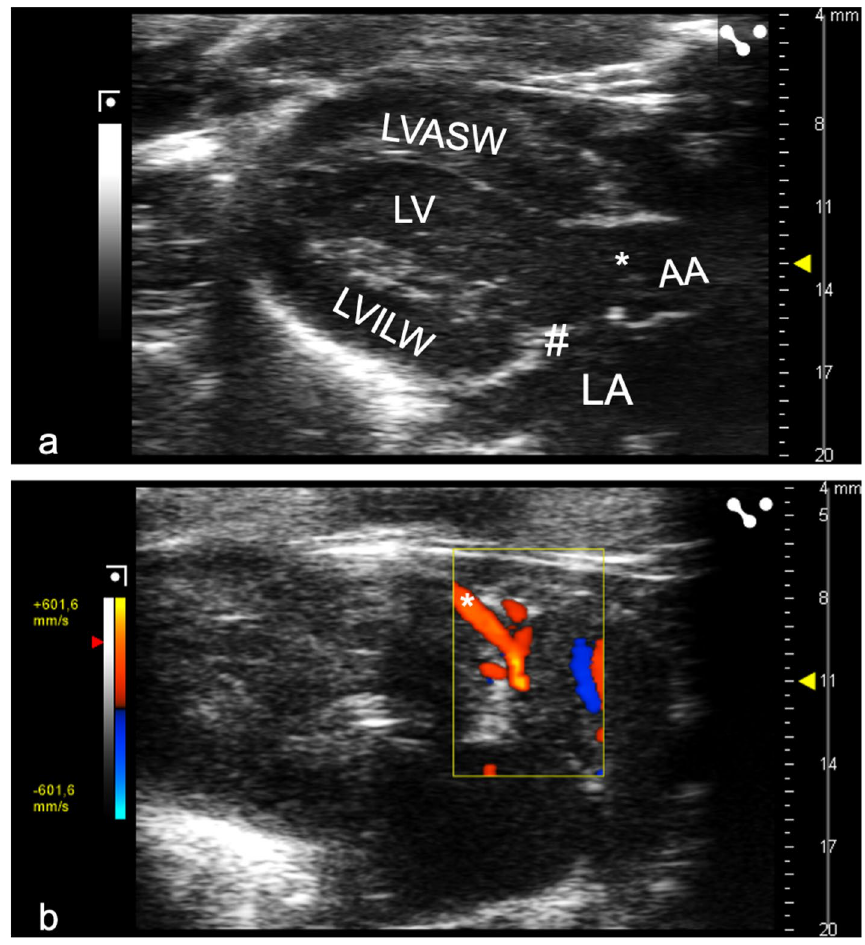
Fig. 2 Representative B-mode and colour Doppler images acquired in a parasternal long axis (PLAX). a B-mode PLAX of the left ventricle. These images were used for volumetric and perfusion measurements. AA Ascending aorta, LA Left atrium, LV Left ventricle, LVASW Left ventricular anteroseptal wall, LVILW Left ventricular inferolateral wall, * aortic valve, # mitral valve. b Exemplary colour Doppler image of the proximal left coronary artery, which was assessed by pulsed-wave Doppler in the following step. * Proximal left coronary